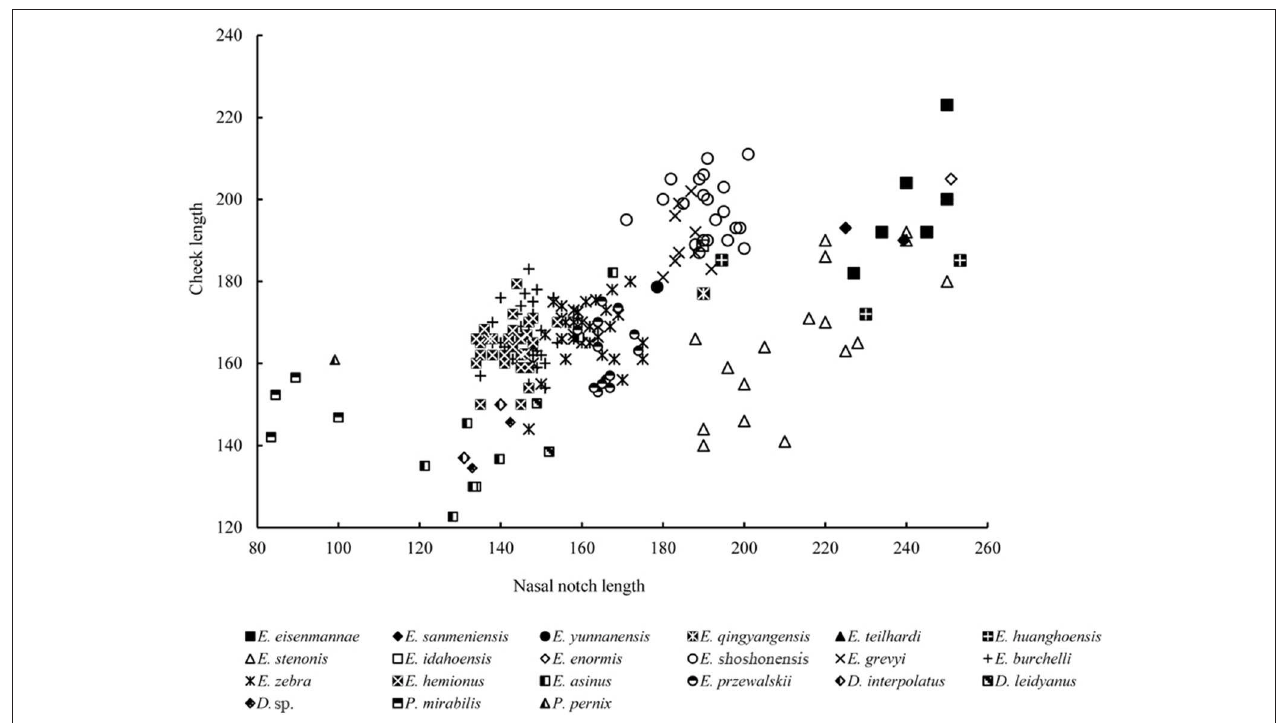
FIGURE 12 | Comparison of lengths of nasal notch and cheek in several extinct and extant species of